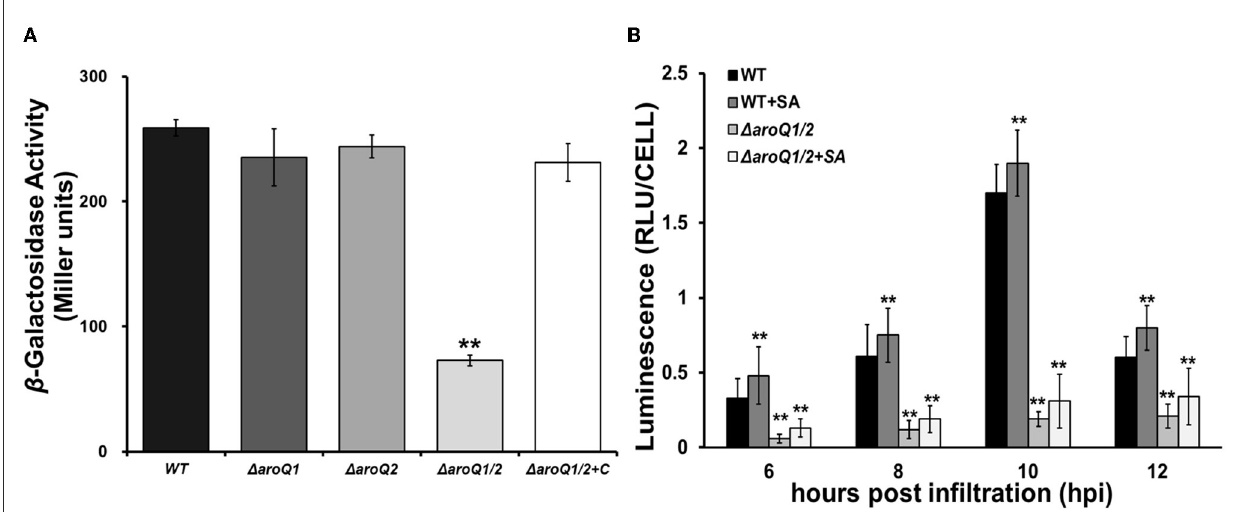
FIGURE3 Involvement of AroQ on T3SS expression ( popA-lacZY A, a representative T3SS gene). (A) Expression of popA-lacZYA in SA-supplemented hrp -inducing minimal medium; (B) expression of popA-lacZYA in tobacco leaves. WT, RK5050 (OE1-1, popA-lacZYA ); 1 aroQ1 , RQ5920 (RK5050, 1 aroQ1 ); 1 aroQ2 , RQ5908 (RK5050, 1 aroQ2 ); 1 aroQ1/2, RQ5951 (RK5050, 1 aroQ1/2 ); 1 aroQ1/2 + C, and RQC1634 (RQ5951 with complementary aroQ1 ). + SA, supplementary shikimic acid (SA) in tobacco leaves. For the in vitro enzyme assay, strains were grown in the hrp -inducing minimal medium with supplementary SA at 300 µ M to an OD 600 of 0.1 and subjected to enzymatic measurement, enzymatic activities of which were presented in Miller units. Each assay was repeated with three biological replicates, including three replicates per trial. For the in planta enzyme assay, tobacco leaves were infiltrated with a bacterial suspension of 0.1 OD 600 or with supplementary SA at 300 µ M. Leaf disks were punched for enzymatic measurement with the Galacto-Light Plus kit, the enzymatic activities of which were presented with luminescence normalized by cell number (RLU cell − 1). The in planta enzyme assay was carried out to ∼ 12h post-infiltration (hpi). At this point, infiltrated regions of tobacco leaves with bacterial cells became clear scald. Luminescence was determined using the GloMax20 Luminometer (Promega), and cell numbers in punched leaf disks were quantified by dilution plating. Each assay was carried out with more than four biological replicates including six replications per trial. Mean values of all experiments were averaged with SD, and statistical significance between mutants and RK55050 was assessed using a post-hoc Dunnett’s test following ANOVA. Significance level, ** indicates P <